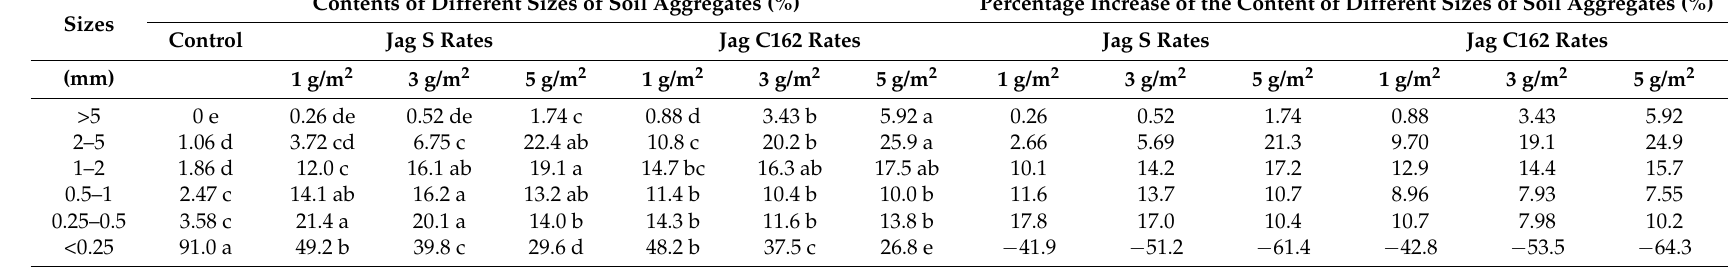
Table 1. Increase of the content of different sizes of soil aggregates.